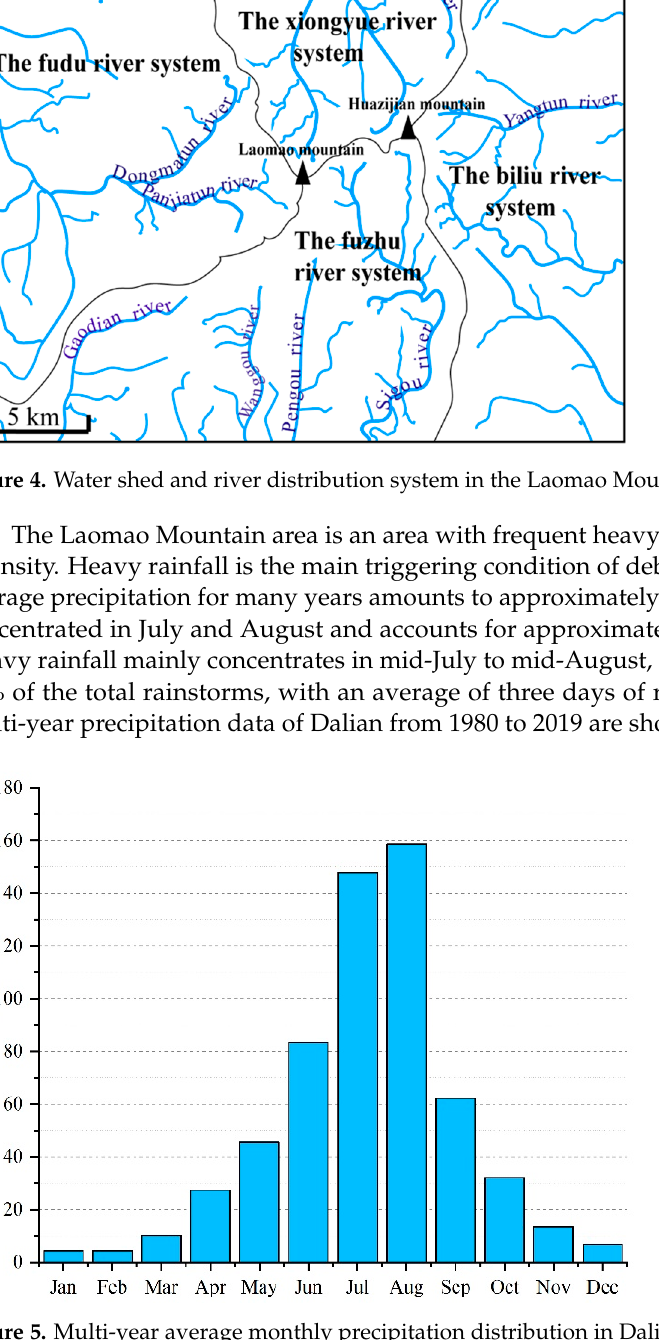
Figure 5. Multi-year average monthly precipitation distribution in Dalian from 1980 to 2019.